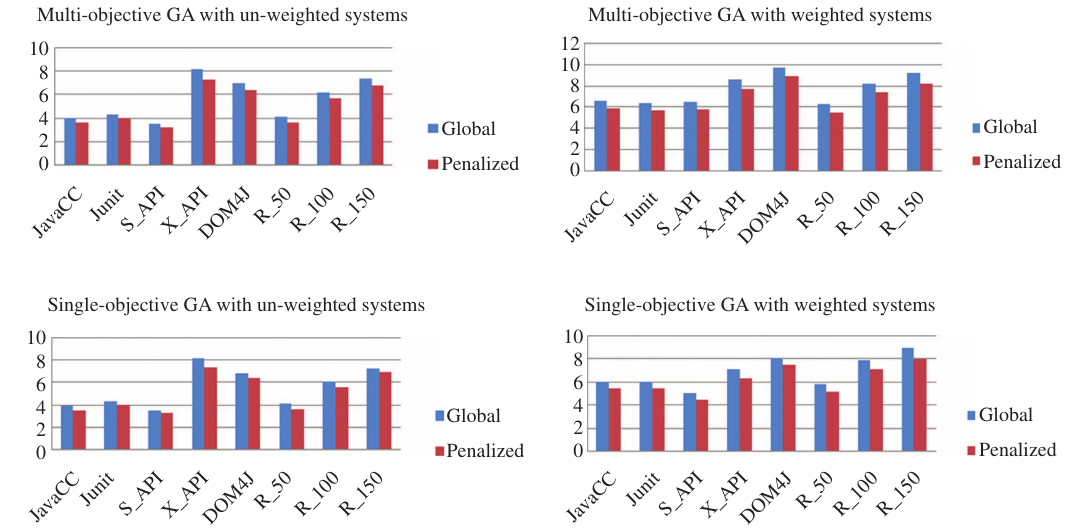
Figure 3: Analysis of MQ Values in Penalized Optimization from Global Optimization.